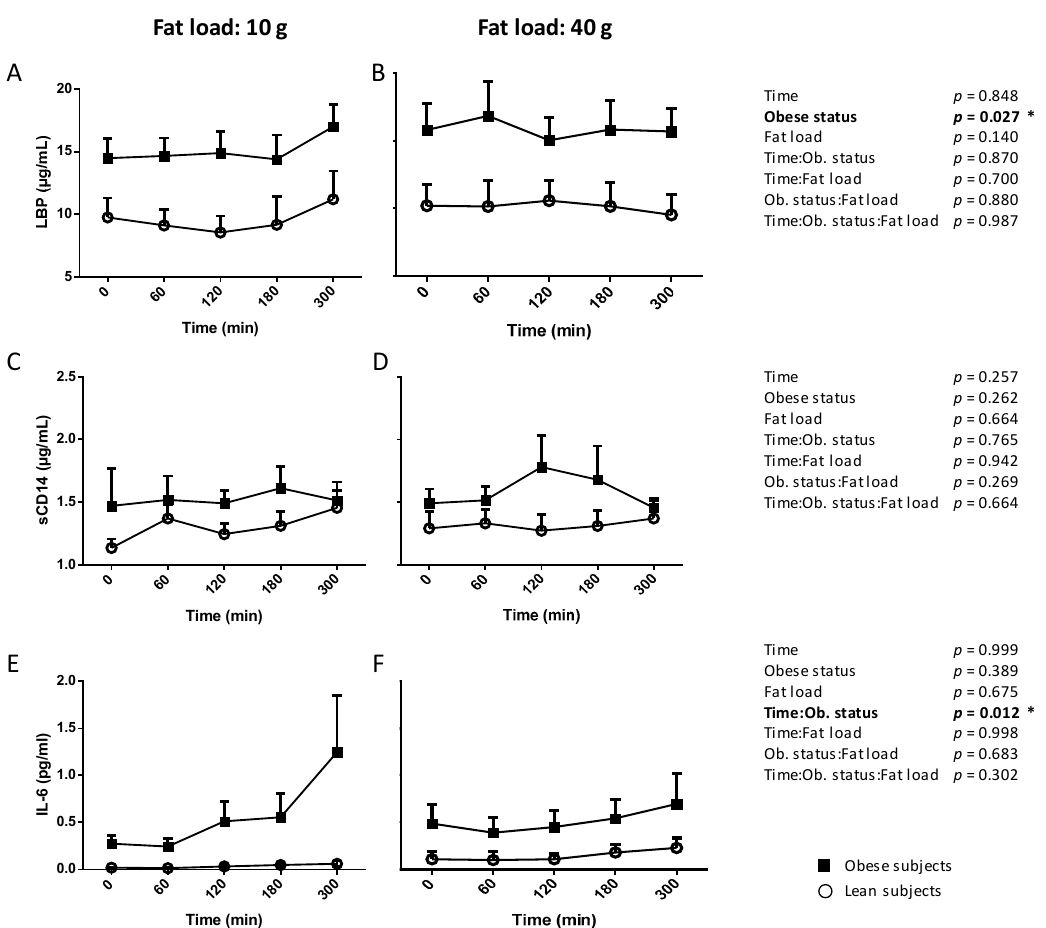
Figure 1. Postprandial kinetics in plasma of lipopolysaccharides (LPS)-binding protein (LBP) ( A , B ); sCD14 ( C , D ); and Il-6 ( E , F ) in normal-weight and obese subjects after 10 g vs. 40 g fat load. Data are means ± SEM. * p < 0.05.